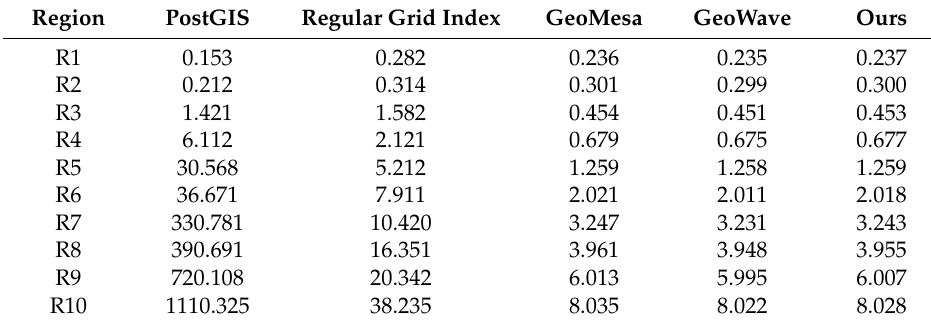
Table 7. Execution time of the range query with each region of five methods